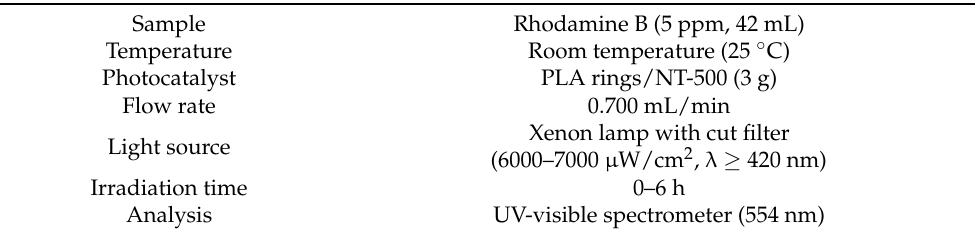
Table 1. Experimental conditions for degradation Rhodamine B (RhB) by flow method under visible light